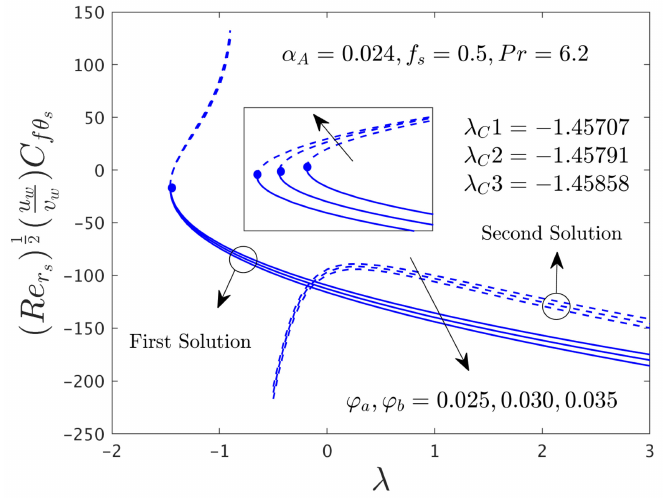
(cid:16) (cid:17) u w C f θ versus λ for numerous choices of the hybrid nanoparticles. v w s s